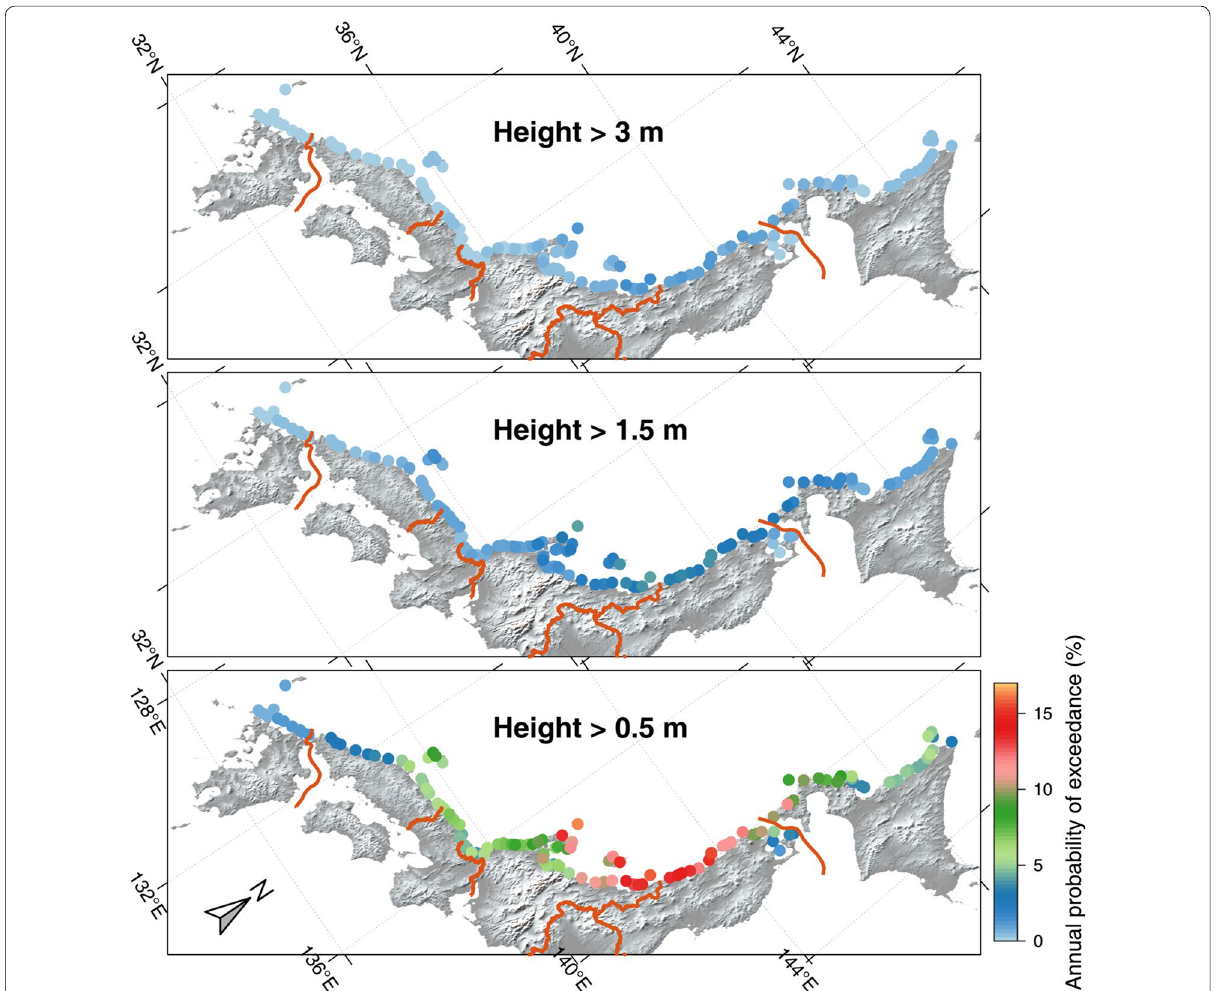
Fig. 9 Annual probability of experiencing tsunami with heights of more than 0.5, 1.5, and 3 m. Red lines mark region